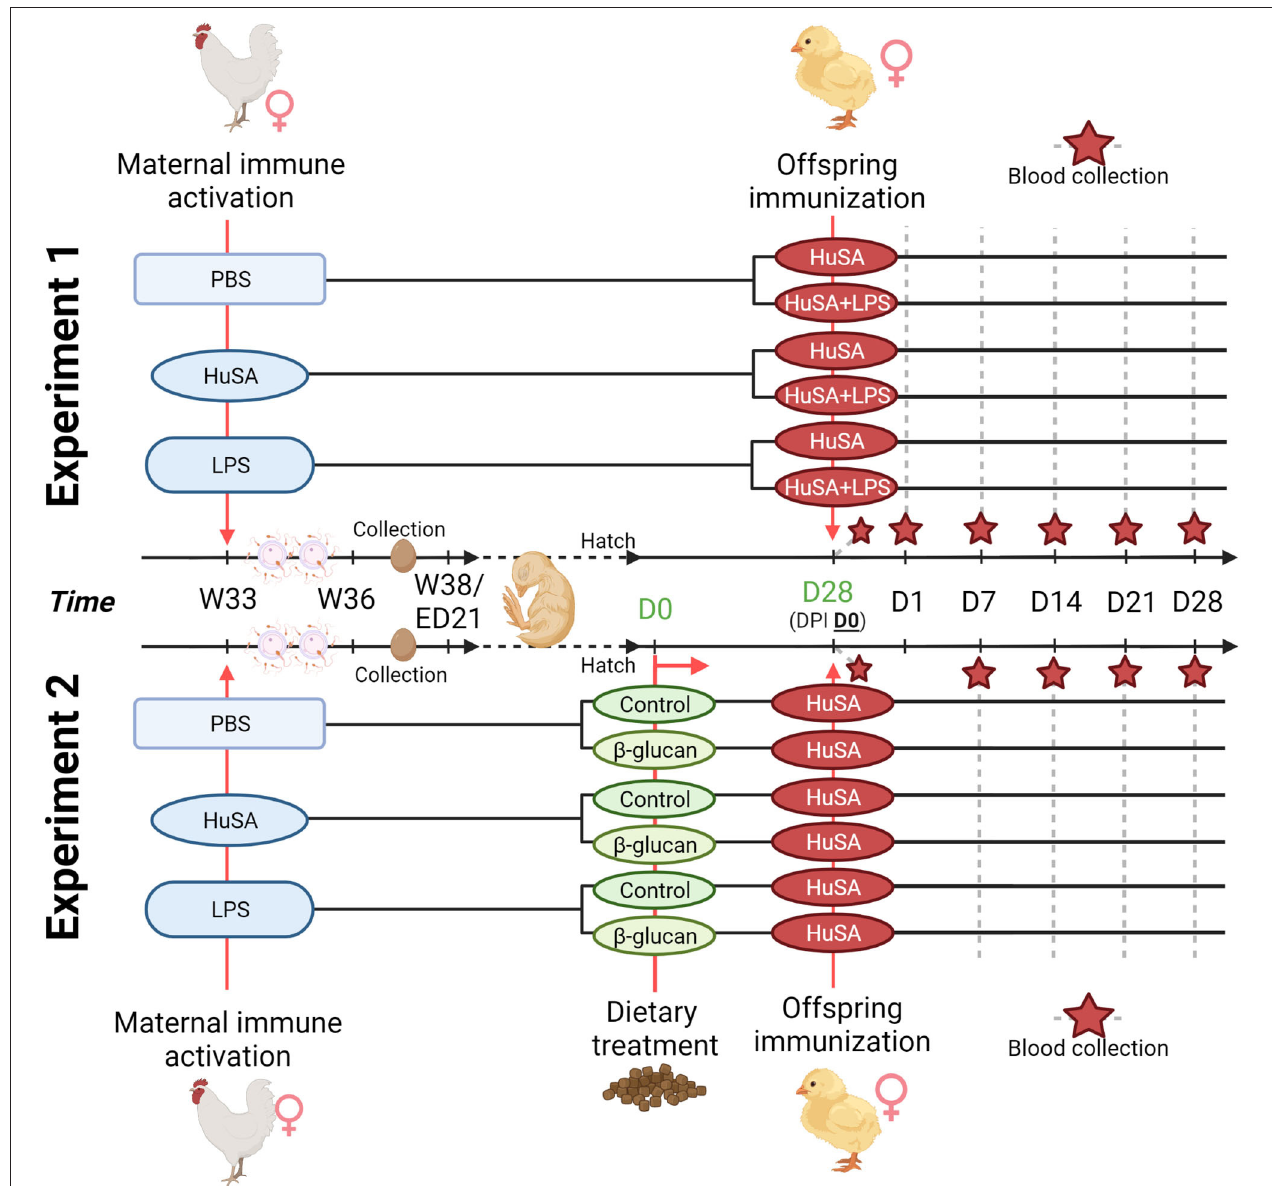
FIGURE 1 | Timeline of the two transgenerational experiments. For both experiments, maternal immune activation with PBS, HuSA and LPS was performed on 33-week-old hens (W33). Hens were inseminated with pooled sperm at the day of immunization and repeated 2 weeks later. Eggs were collected when the hens reached the age of 36 weeks (W36) until 38 weeks of age (W38). For experiment 1, hatched chicks received at 28 days of age (DPI D0), the immunization with HuSA or HuSA + LPS. Blood was collected at DPI: D0, D1, D7, D14, D21 and D28 (marked with a red star). For experiment 2, hatched chicks received either a commercial starter diet (control) or a commercial diet enriched with a β -glucan additive ( β -glucan). Chicks received at 28 days of age (DPI D0), the immunization with HuSA. Blood was collected at DPI: D0, D7, D14, D21 and D28 (marked with a red star). Figure created with BioRender.com.